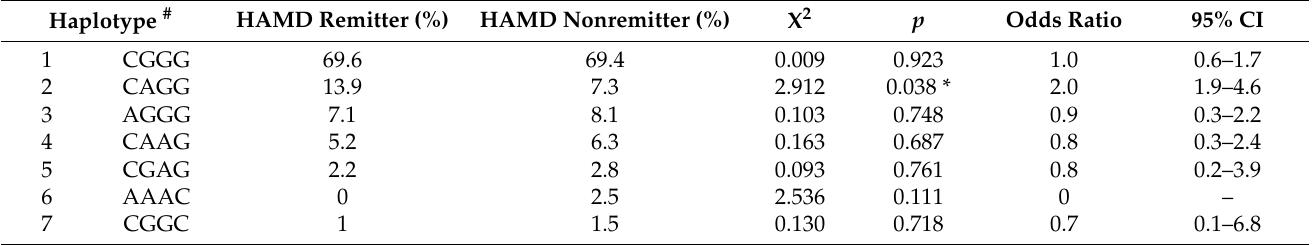
Table 4. Haplotype frequencies of the 4 polymorphisms in the LEPR gene in HAMD remitters and nonremitters.